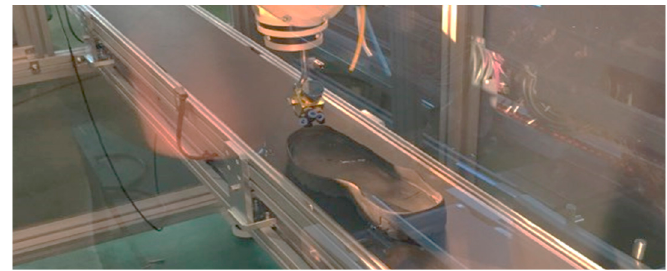
Figure 15. Dispensing glue on contour of sole using robot.